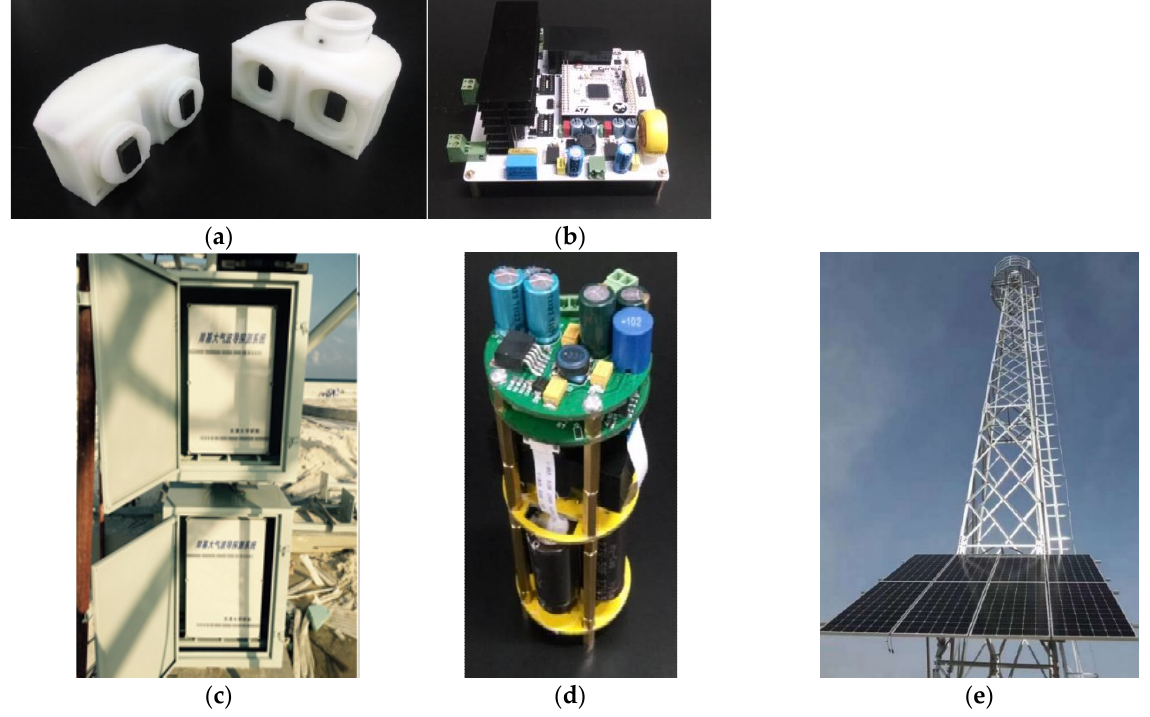
Figure 2. The physical photo of measurement system components of the evaporation duct. ( a ) Inductive couplers; ( b ) master circuit; ( c ) sealed box (it is used to store the solar controller); ( d ) multiple sensing units; ( e ) solar battery boards.